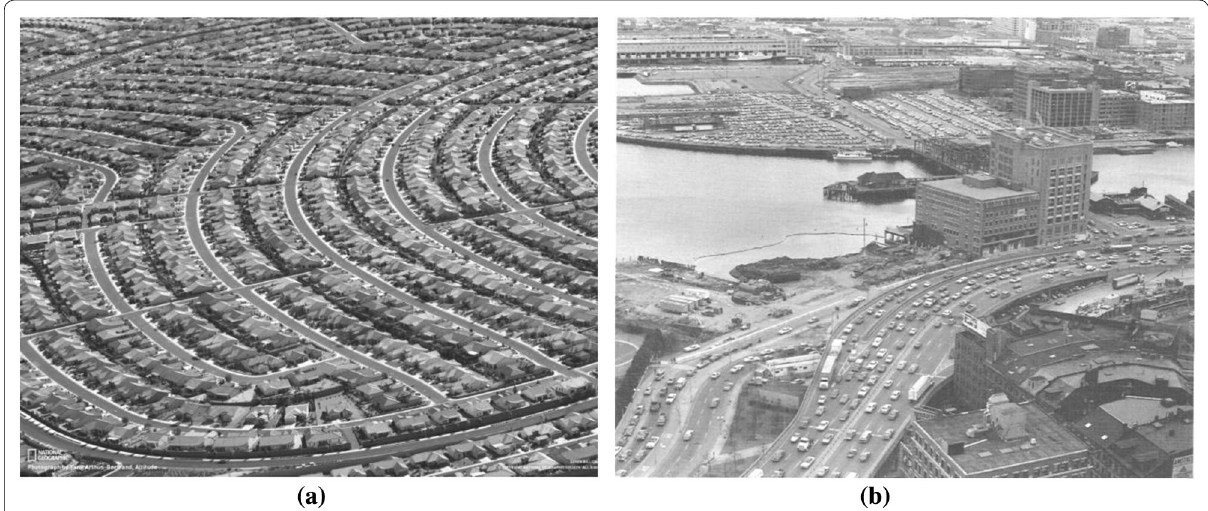
Fig. 4 Symptoms of modern urban fragmentation, exclusive zoning, and dominance of cars. a Vast expanses of disconnected suburban areas. b Highways, extensive parking, and fragmented